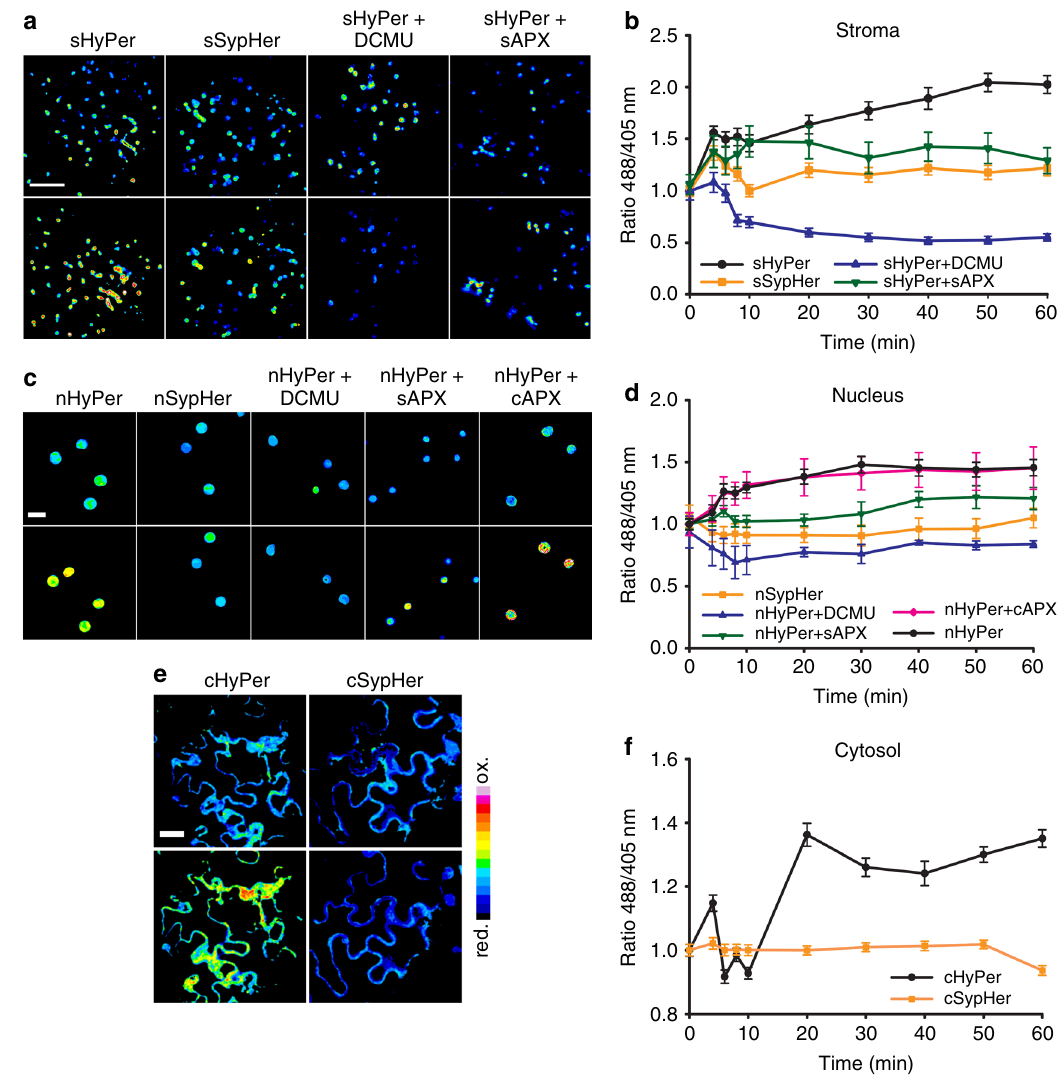
Fig. 2 Time course of HyPer2 and SypHer2 responses to HL expressed in different subcellular compartments of N. benthamiana epidermal cells. a , b N. benthamiana abaxial epidermal cells expressing sHyPer2 and sSypHer2. a 488/405nm ratio images of resting state in the dark ( upper row ) and after 60 min HL ( lower row ). From left to right, the panels show the fl uorescence of chloroplasts of cells from leaves expressing sHyPer2, sSypHer2, sHyPer2 treated with DCMU (10 µ M for 20 min prior to illumination) and over-expressing sAPX, respectively b The effect of exposure to HL over 60 min on the 488/405nm fl uorescence ratio of chloroplasts in epidermal cells expressing sHyper2 and sSypHer 2. The data points were normalised to the mean initial value for each treatment and represent the mean ± SEM values from 40 – 70 chloroplasts from 3 independent experiments per treatment. c , d Equivalent to panels a and b except that the cells expressed nHyPer2 and nSypHer2. From left to right, the panels show the fl uorescence from nuclei expressing nHyPer2, nSypHer2, sHyPer2 treated with DCMU (10 µ M for 20 min prior to illumination), over-expressing sAPX and cAPX, respectively. The data points were normalised to the mean initial value for each treatment and represent the mean ± SEM from 8 – 18 nuclei from 3 independent experiments per treatment. e , f N. benthamiana abaxial epidermal cells expressing cHyPer2 and cSypHer2. e 488/405nm ratio images of resting state in the dark (upper row) and after 60 min HL (lower row) of cHyPer2 and cSypHer2 right and left column, respectively. f Quanti fi cation of the HL-dependent changes in cHyPer2 and cSypHer 2 fl uorescence over 60 min HL. The data points were normalised to the mean initial value for each treatment and represent the mean ± SEM from 12 – 15 cells from 3 independent experiments per treatment. Scale bar = 50 µ Table 1). The detection of light-dependent H 2 O 2 in the chloroplasts is consistent with previous observations using chemical probes 11, 16 . By comparing the response curves of HyPer2 and SypHer2 in the nuclei (Figs. 2c, d) and cytosol (Figs. 2e, f) we concluded that HL also causes an increase in H 2 O 2 over a similar time course in these compartments. Indeed, the best fi tting GAMMs to the changed in F488/F405 in both the cytosol and nucleus included different smooth functions for the time-series of HyPer2 and SypHer2 (Supplementary Fig. 5b, c; Supplementary Table 1).